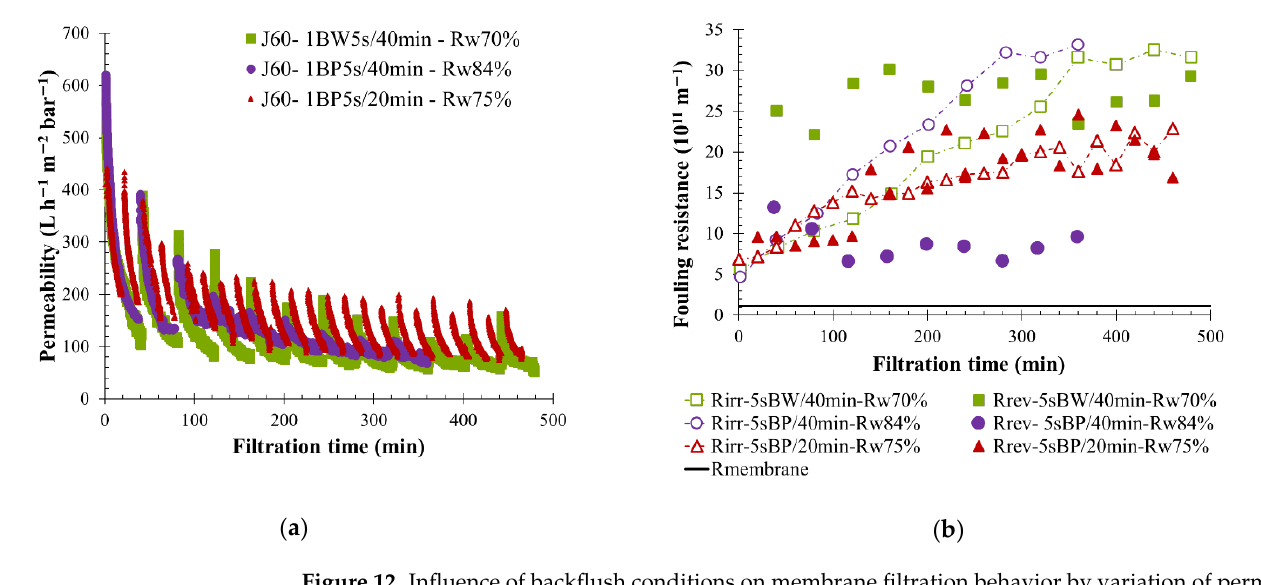
Figure 12. Influence of backflush conditions on membrane filtration behavior by variation of permeability at 20 ◦ C ( a ); fouling resistance ( b ) throughout the time with pressured water injected during 5 s and a permeate flux of 90 L h − 1 m − 2 . The filtration conditions as BF mode, frequency and volume injected are, respectively, BW, 40 min, 5.5 L (squared); BP, 40 min, 1.7 L (round) and BP, 20 min, 1.7 L (triangle). T = 20 ◦ C, feedwater from CC-KERGUELEN; SiC membrane 0.33 m 2 . Jxx is permeate flux at the xx value in L h − 1 m − 2 ; 1BW yy s/zz min where yy is the duration and zz the interval of filtration between two BF; and Rw is the total recovery rate applied on the unit; R irr is irreversible resistance; R rev is reversible resistance and R membrane is the membrane resistance.